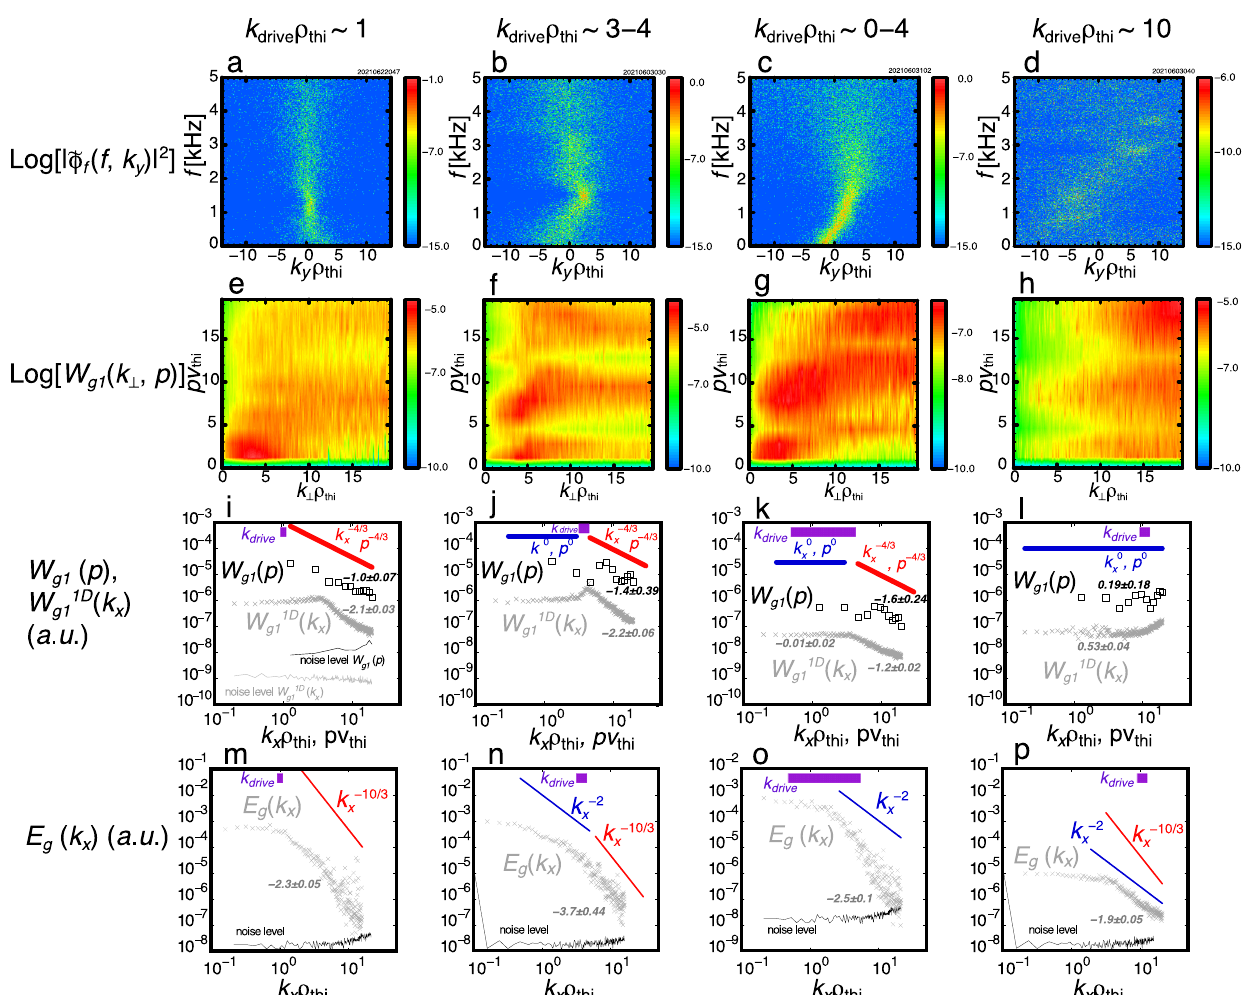
Fig. 2 Variation in spectra of the invariants of gyro-kinetics. The free energy W g1 ( k ⊥ , p ) and the electrostatic energy E g ( k ⊥ ) for varied driving perpendicular wavenumbers k drive ρ thi between ~0 and 10, (the 1st column) k drive ρ thi ~ 1, (the 2nd column) k drive ρ thi ~ 3 − 4, (the 3rd column) k drive ρ thi ~ 0 − 4, ð f ; k Þj 2 measured by FSLP. and (the 4th column) k drive ρ thi ~ 10, respectively. The plots in the 1st row ( a – d ) are the power spectra of potential fl uctuation j ~ ϕ x f The plots shown in the 2nd row ( e − h ) are W g1 ( k ⊥ , p ) in the k ⊥ - p -space, namely, position – velocity-space. The 3rd row ( i − l ) are (cross) 1D spectra W g1 1D of the free energy as functions of k x ρ thi and (open square) p -spectra of W g1 ( p ), respectively. E g ( k ⊥ ) spectra are shown in the 4th row ( m − p ). Respective k drive ρ thi ranges are shown by purple color bars. The blue and red bars represent power laws predicted by the gyrokinetic theory 20 for (blue) k ⊥ < k drive and (red) k ⊥ > k drive , are shown by purple bars. The blue and red bars represent the power laws predicted by the gyrokinetic theory for (blue) the inverse-cascade range k ⊥ < k drive and (red) the forward cascade range k ⊥ > k drive , respectively 20 . The respective power indices of W g1 1D ( k x ) and W g1 ( p ) evaluated from the least-square fi tting to the measured data points are indicated by numbers with the standard errors ( SE ). The noise levels of W g1 1D ( k x ) and W g1 ( p ) estimated from a vacuum shot are included in Fig. 2i. W g1 ( p ) in Fig. 2i (injection at a large scale) shows power-law decay starting at k x ρ thi ~ k drive ρ thi ~ 1 up to the detection limit of k x ρ thi ~ pv thi ~ 20, clearly indicating the existence of an inertial subrange of the entropy (free energy). The evaluated exponent for the measured W g1 ( p ), − 1.0, approximately agrees with the theoretical value of − 4/3 within 5 times SE . For smaller scales k x ρ thi > 3, W g1 1D ( k x ) in Fig. 2i shows a similar decaying tendency to W g1 ( p ), which is a strong indication of the dual self-similarity dynamics, although the discrepancy of W g1 1D ( k x ) from the theoretical exponent is larger than 25 times SE . Larger